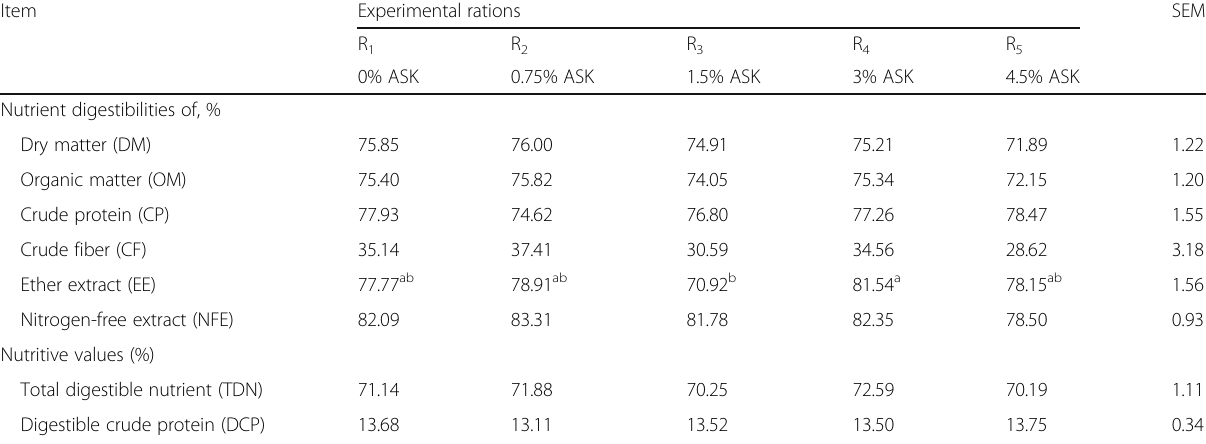
Table 2 Digestion coefficients and nutritive values of the experimental groups